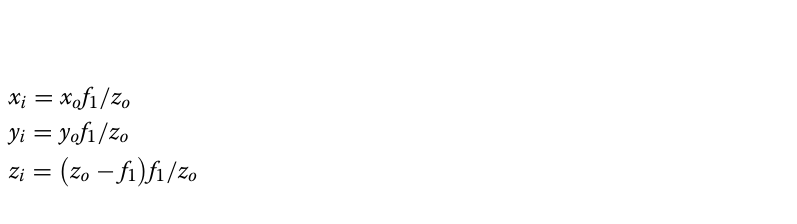
10 elements in aperture for ×